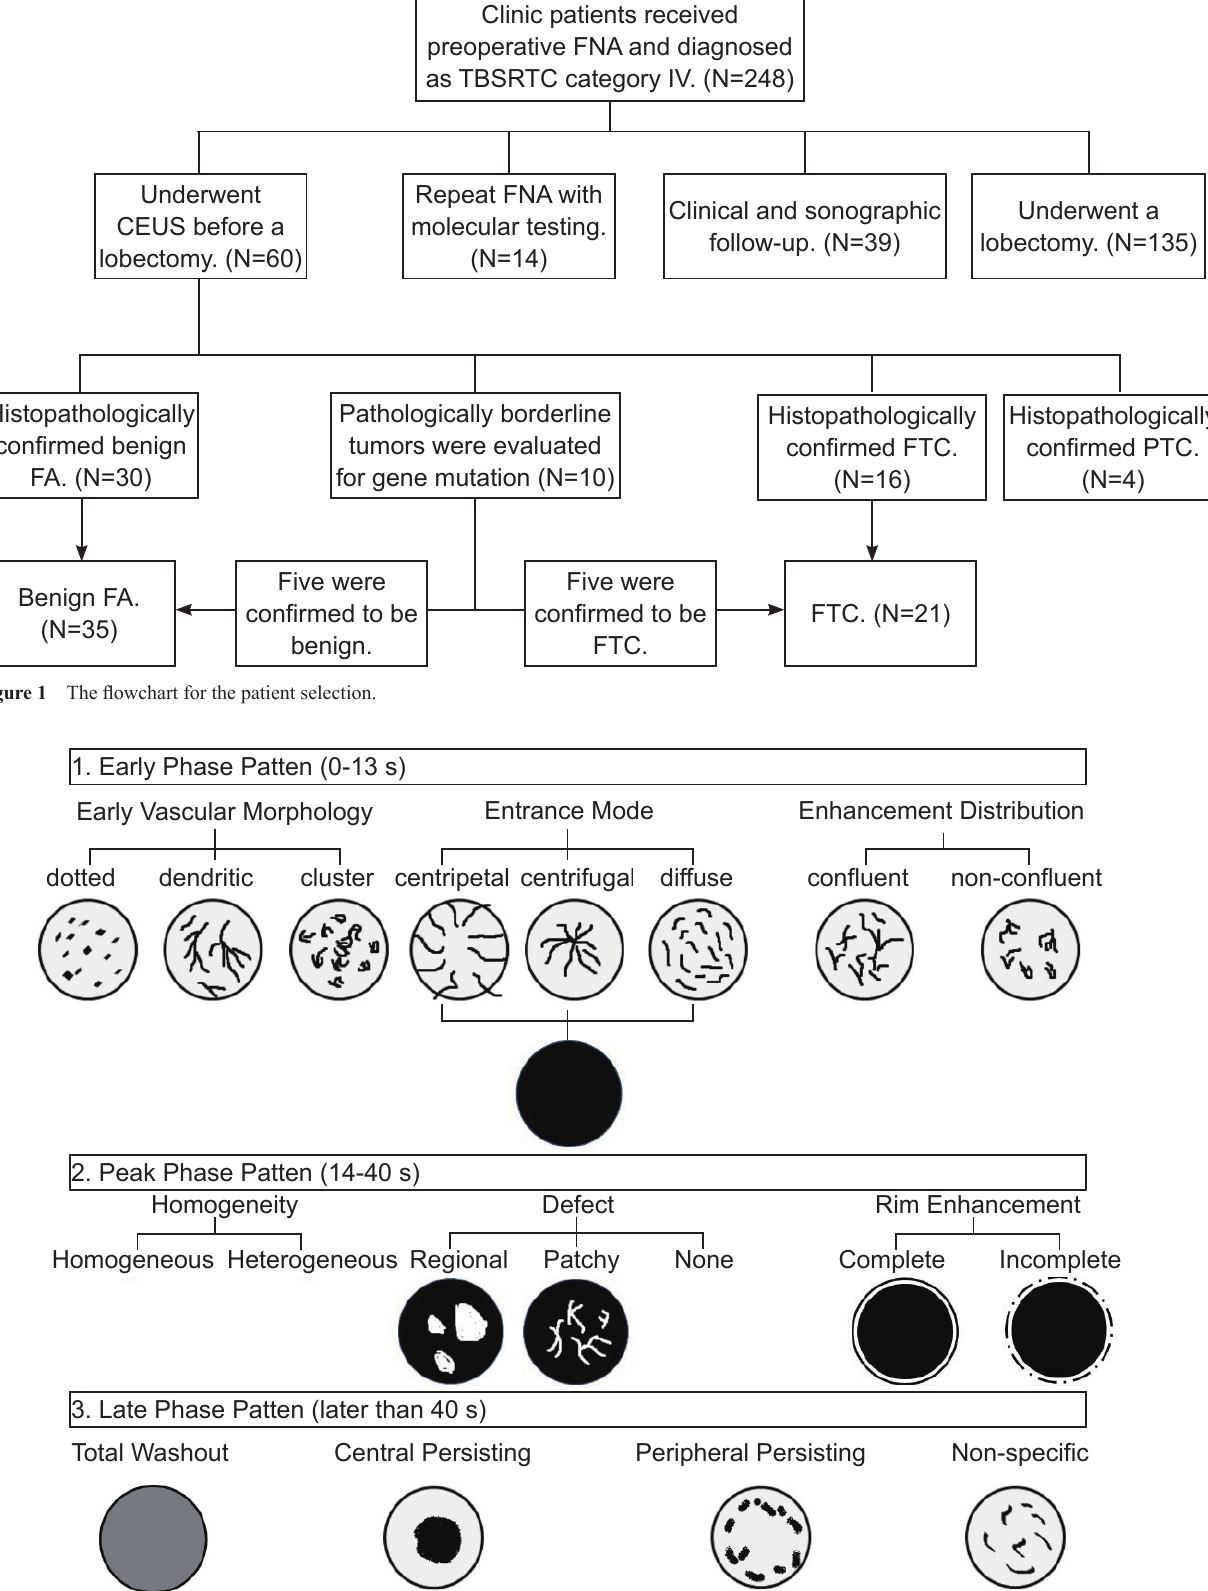
Figure 2 Description of morphologic enhancement patterns. The whole enhancement procedure was classified into three phases: early phase (0-12 s), peak phase (13-40 s) and late phase (later than 40 s). In early phase, enhancement patterns were described as vascular morphology, enhancement mode and enhancement distribution. Peak phase patterns were analyzed in three aspects (homogeneity, defection and rim enhancement patterns). Late phase patterns were presented as total washout, central persisting, peripheral persisting and